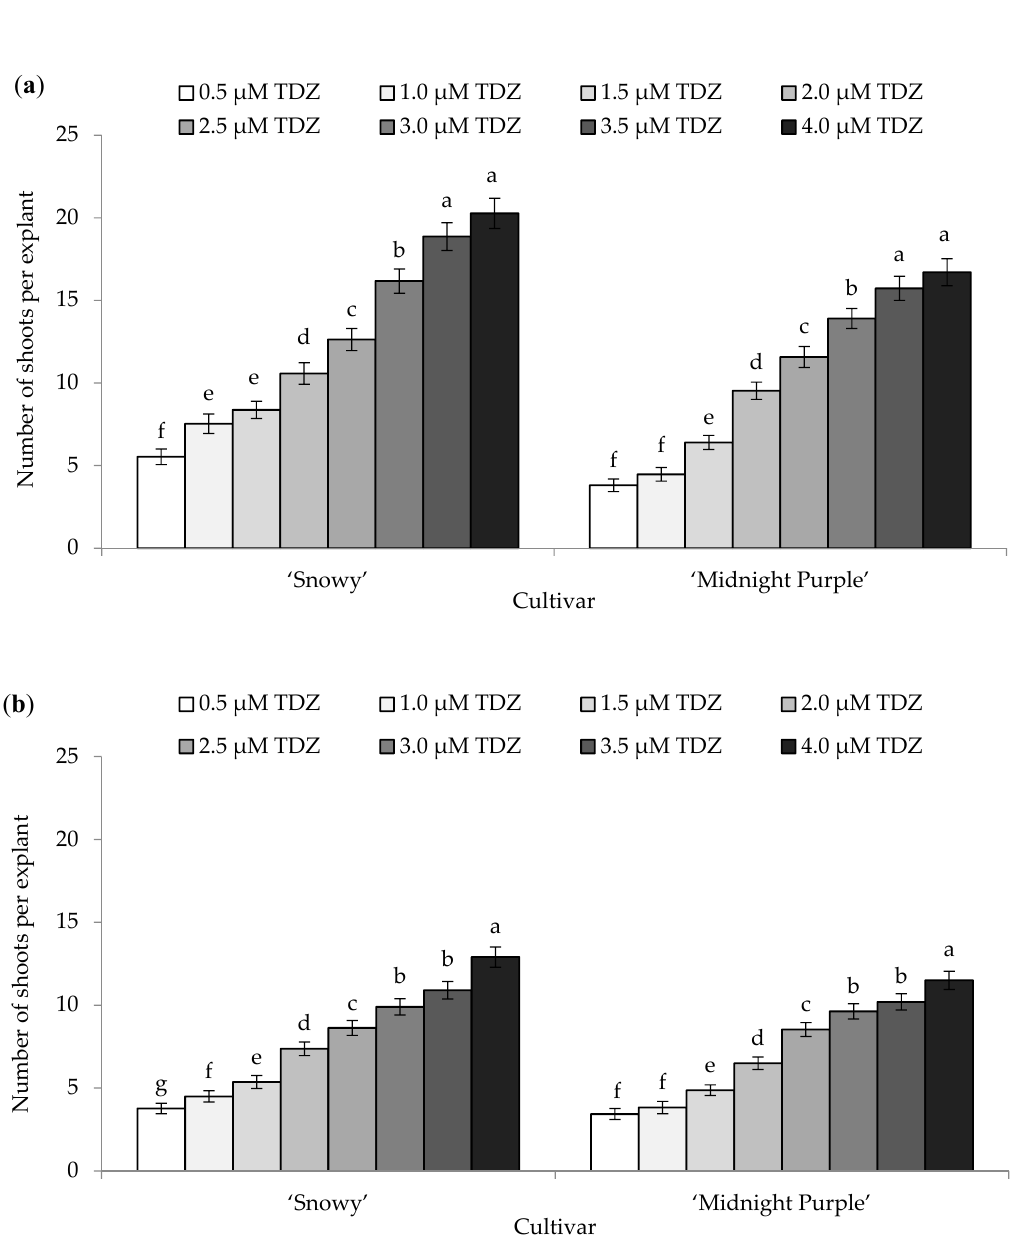
Figure 3. Effect of TDZ concentration on gloxinia number of shoots per explant. Means ± SE of cultivars followed by the same letter were not significantly different at p < 0.01. (( a )—adaxial side down, ( b )—abaxial side down).